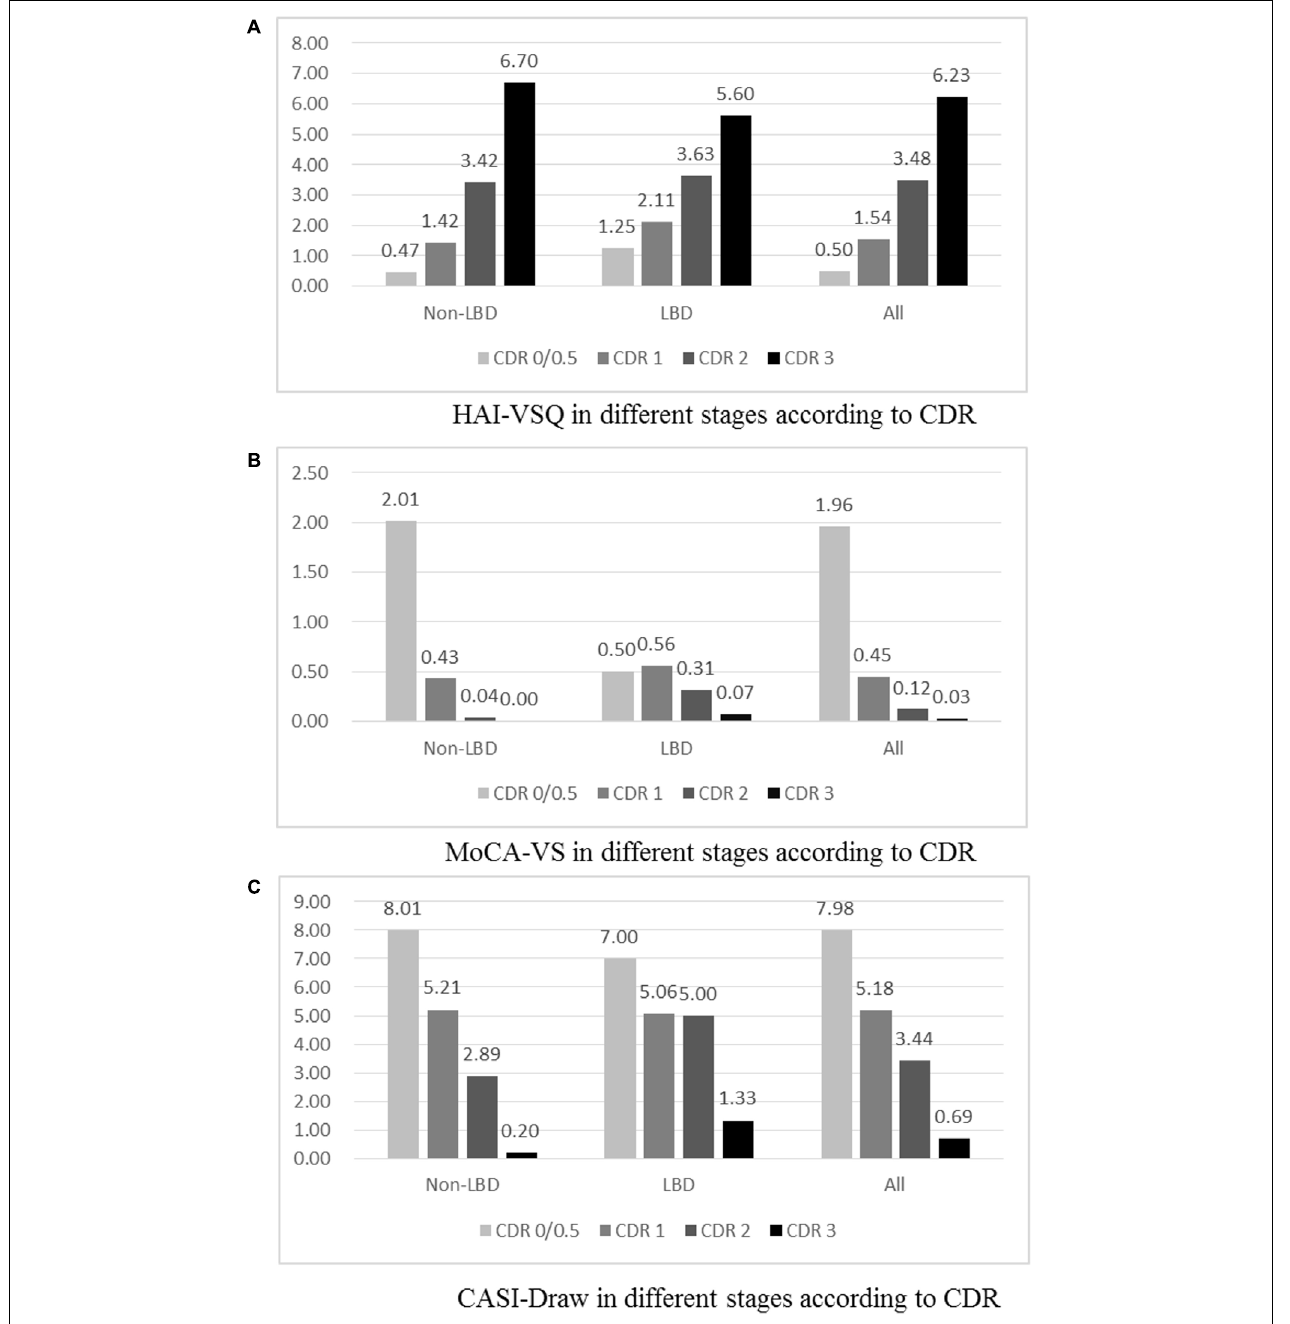
FIGURE 2 | Visuospatial subscales of HAICDDS (HAI-VSQ, A ), MoCA (MoCA-VS, B ), and CASI (CASI-Draw, C ) in different stages of dementia with Lewy bodies (DLB), non-DLB, and all participants. Participants with CDR 0 were classified only in the non-LBD group and all participants. (A) HAI-VSQ in different stages according to CDR. (B) MoCA-VS in different stages according to CDR. (1c) CASI-Draw in different stages according to